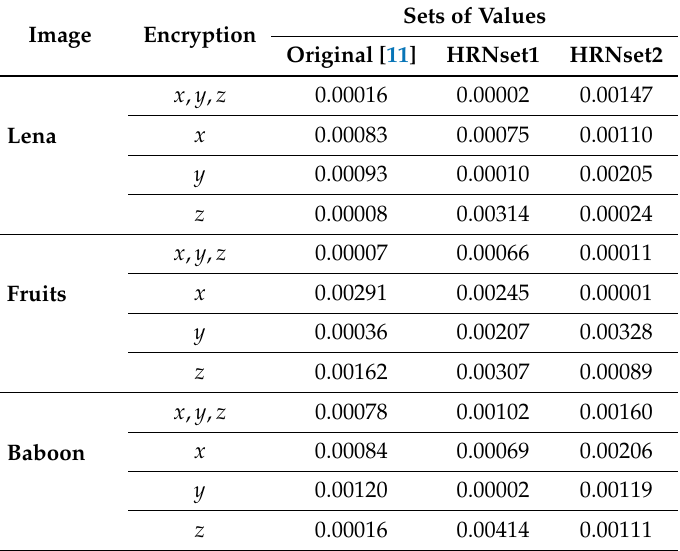
Table 13. Correlations between the chaotic channel and the RGB Lena, Fruits and Baboon images using the sequences generated by the Hindmarsh–Rose neuron for the state variables x , y , and z .